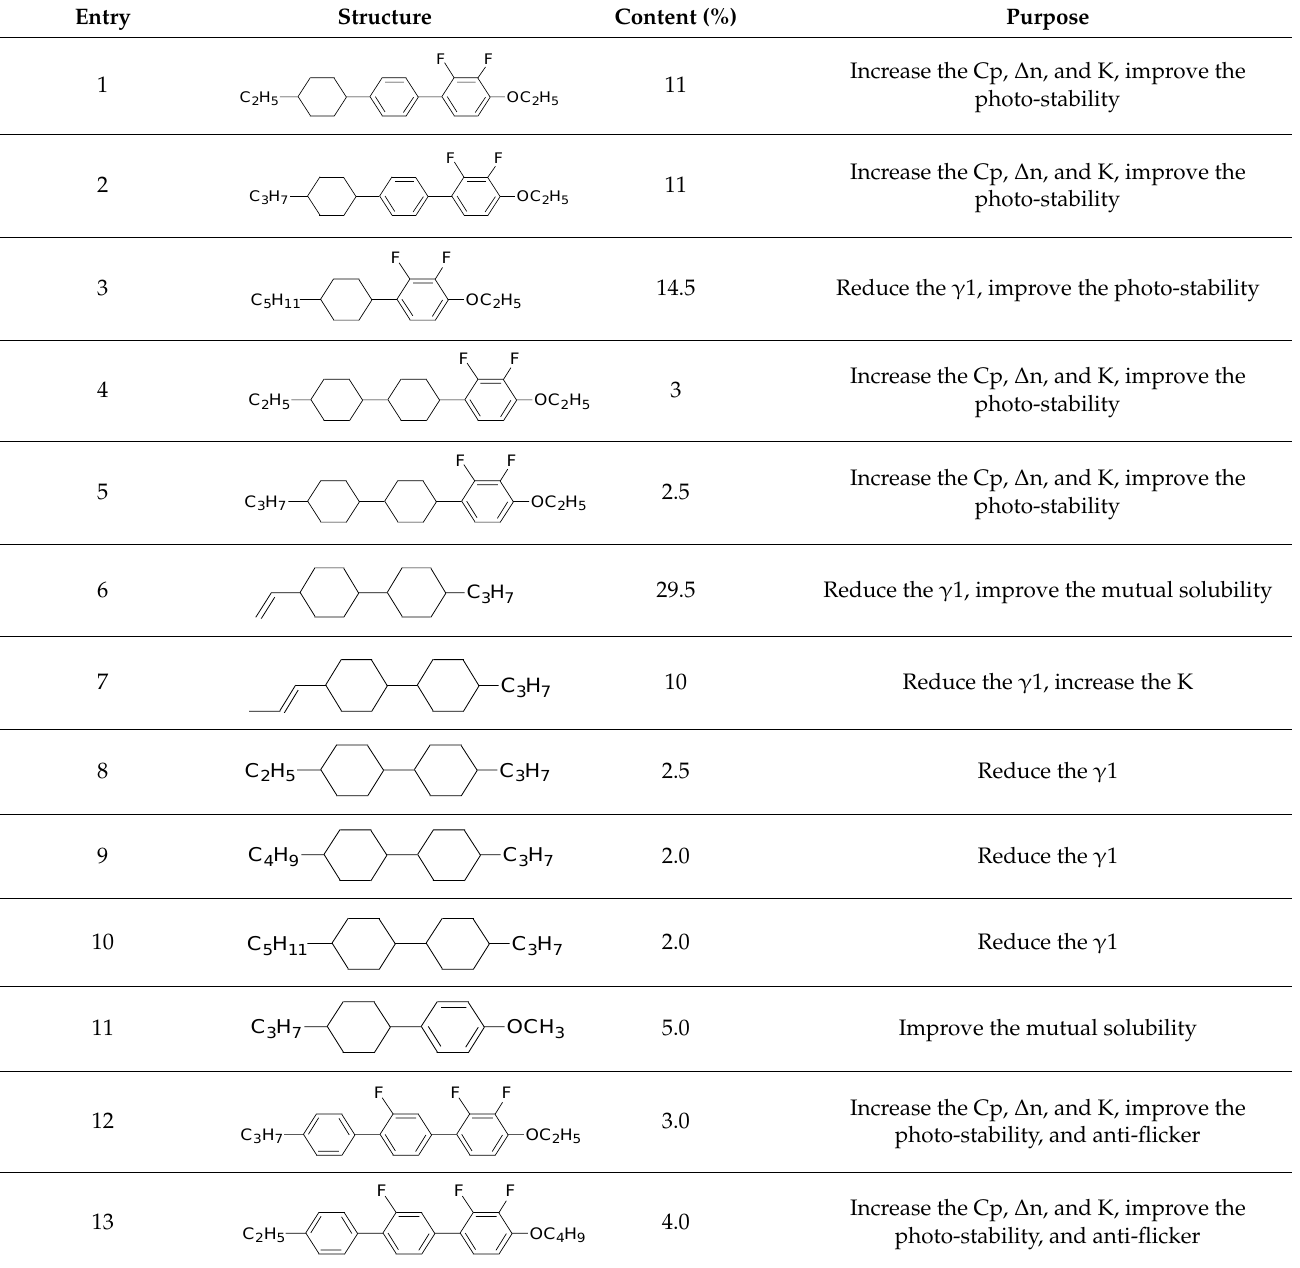
Table 3. The composition of mixed liquid crystal H.